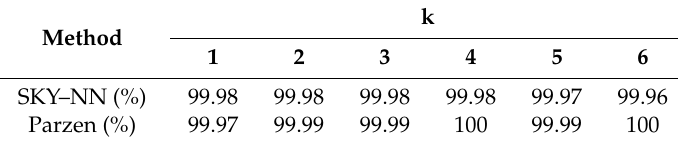
Table 9. Smart skyline on the synthetic Dataset I.